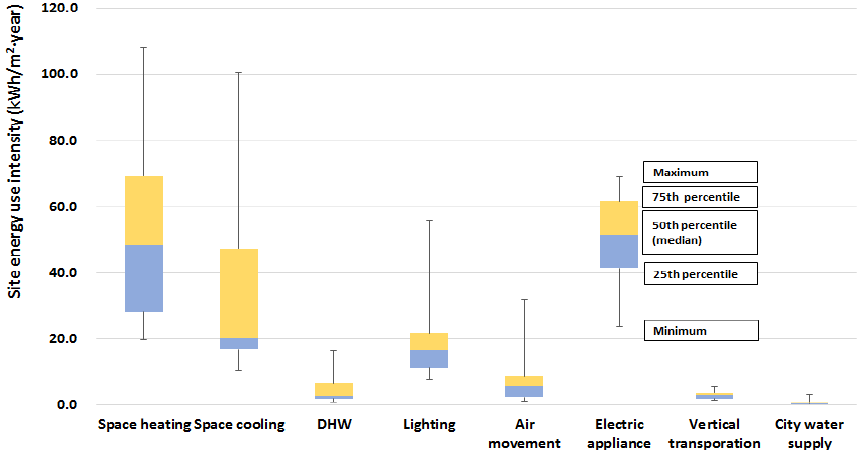
Figure A2. Box plot of site EUIs by end-use (kWh/m 2 ·year).